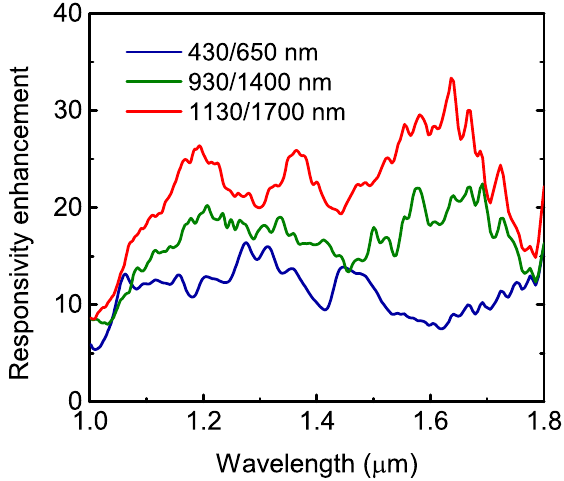
Figure 5. Responsivity enhancement spectra of the Ge/Si QDIPs with photon-trapping hole